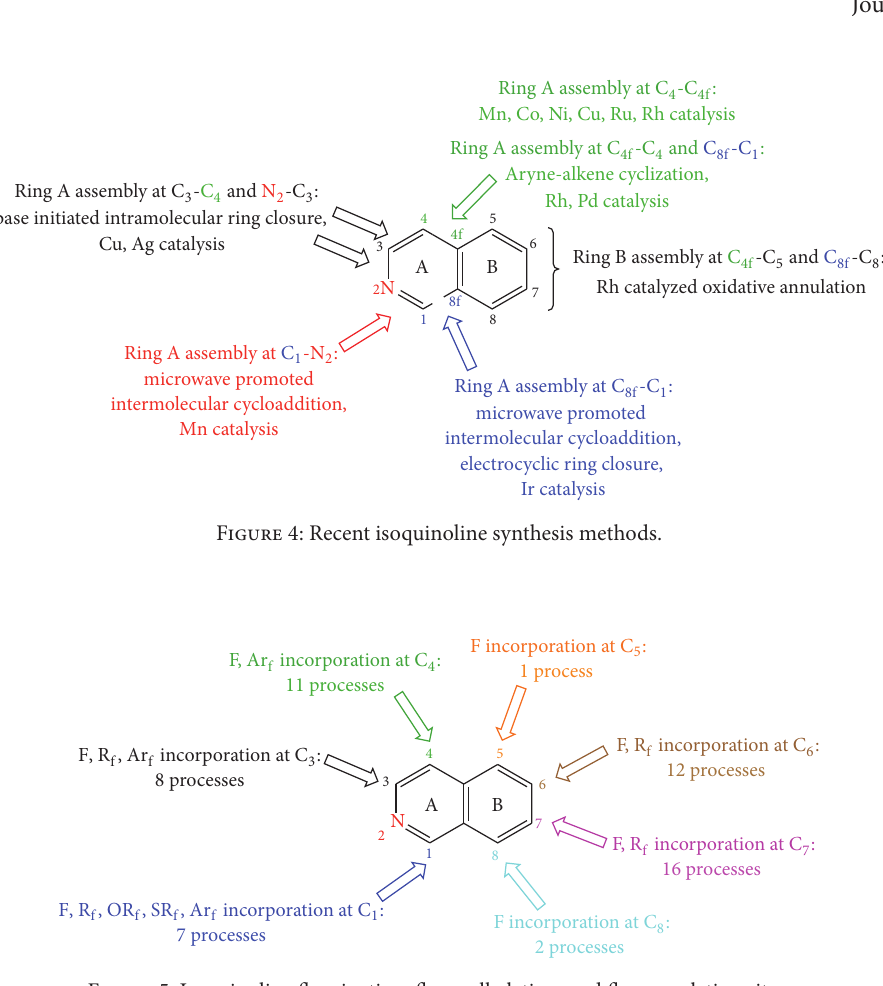
Figure 5: Isoquinoline fluorination, fluoroalkylation, and fluoroarylation sites.